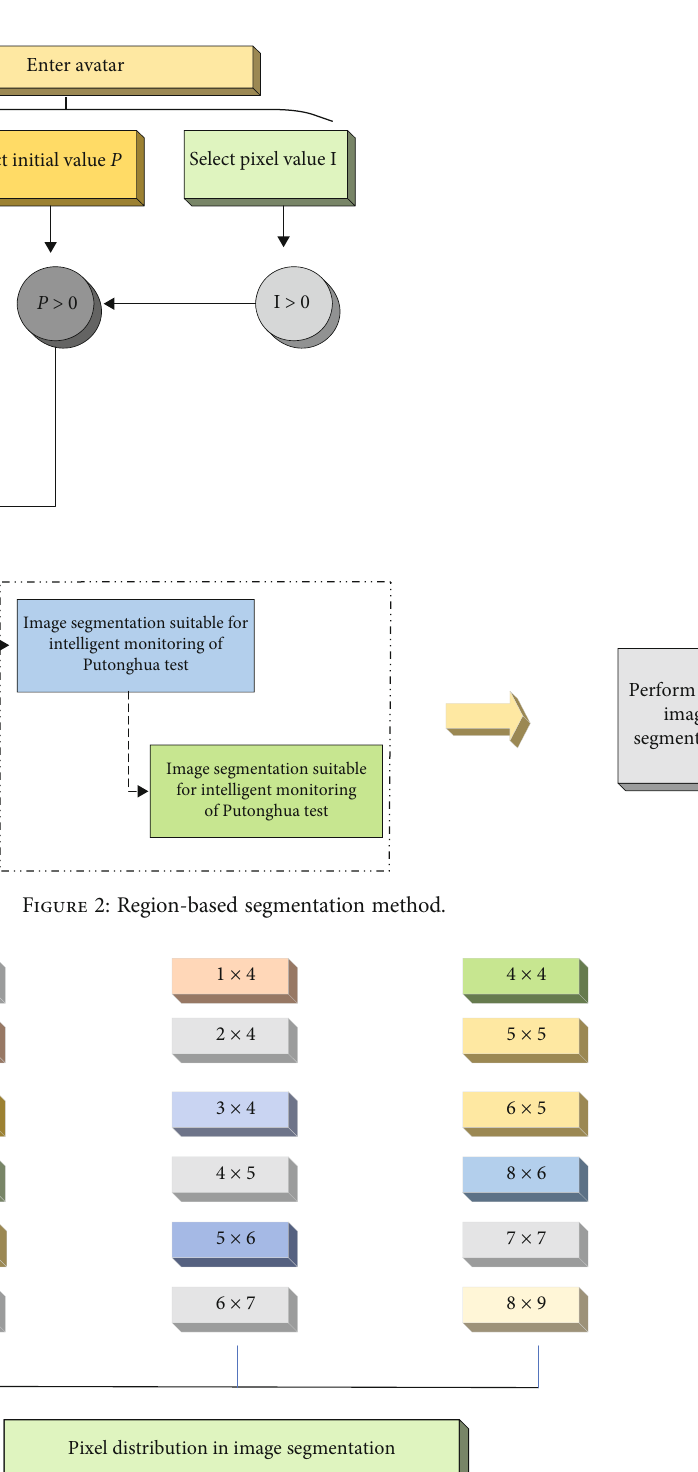
Figure 3: Segmentation method based on convolutional neural